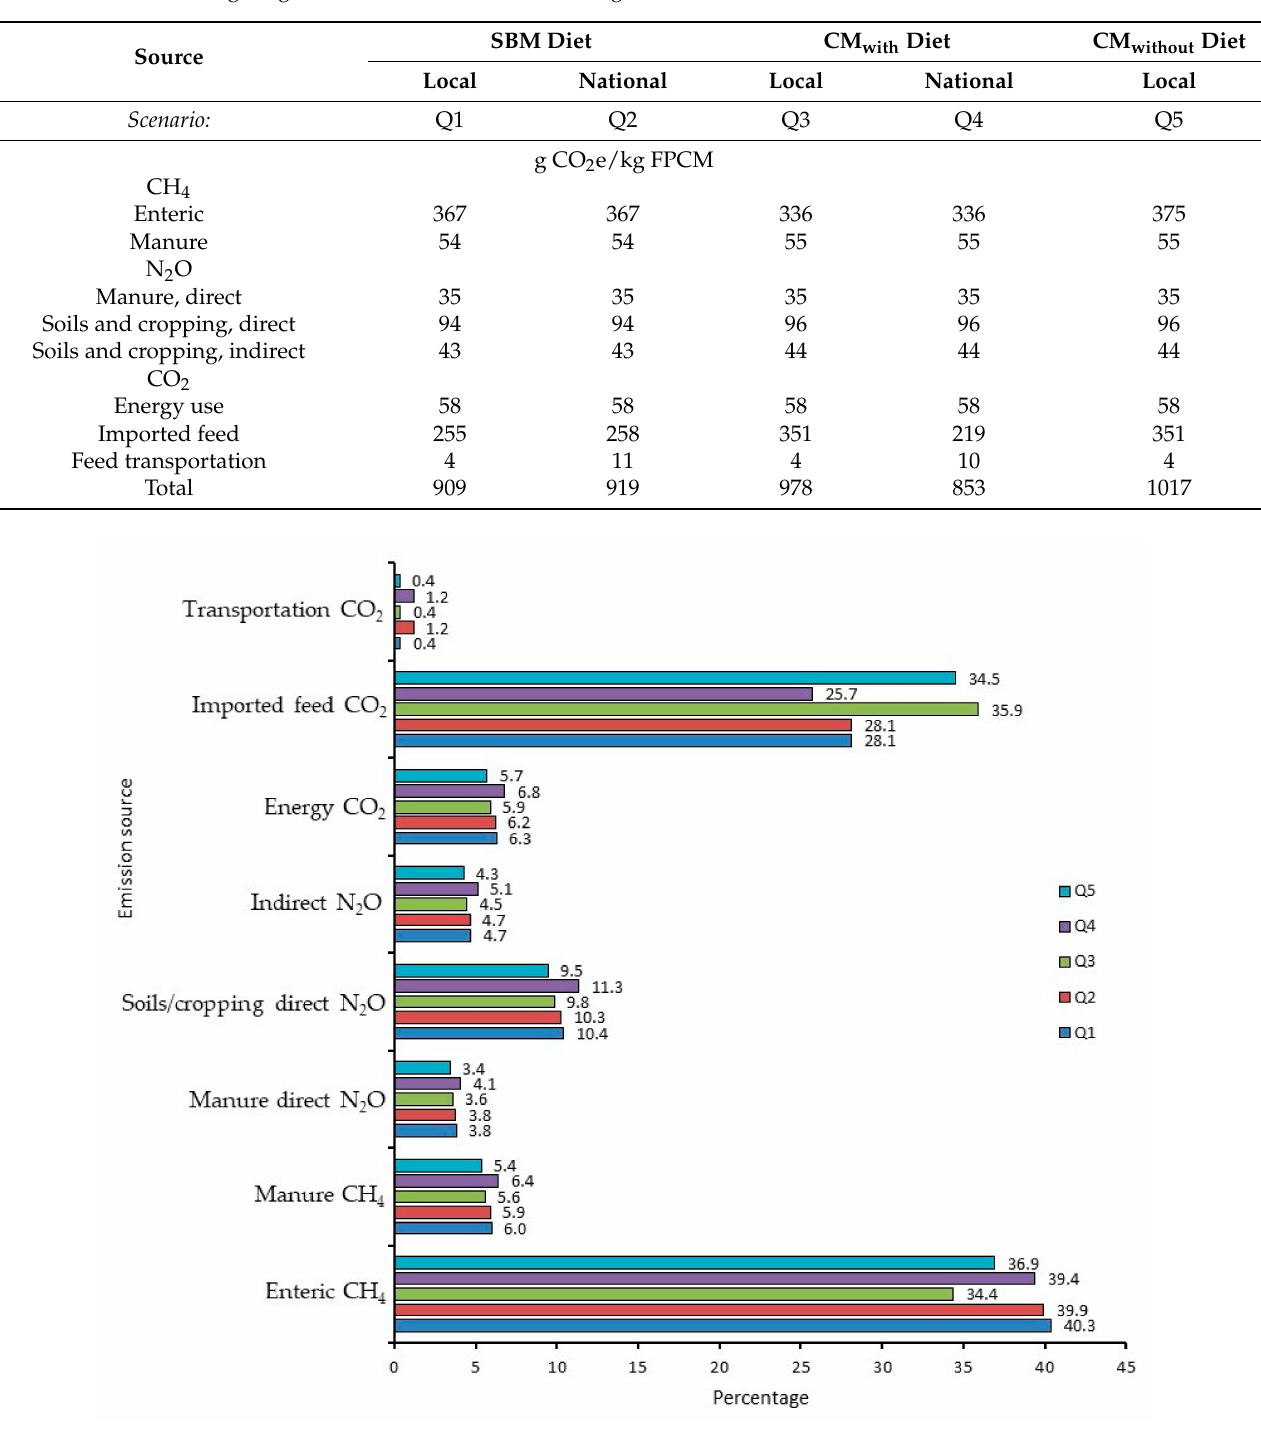
Figure 3. Greenhouse gas proportions of kg CO 2 /kg FPCM for dairy production systems using soybean meal (SBM) or canola meal (CM) in the diets for lactating cows for simulated dairy farms in Quebec. The scenarios were as follows: (Q1) SBM from QC, (Q2) SBM from ON, (Q3) CM from QC with enteric CH 4 mitigation effect, (Q4) CM from SK with enteric CH 4 mitigation effect, and (Q5) CM from QC without enteric CH 4 mitigation